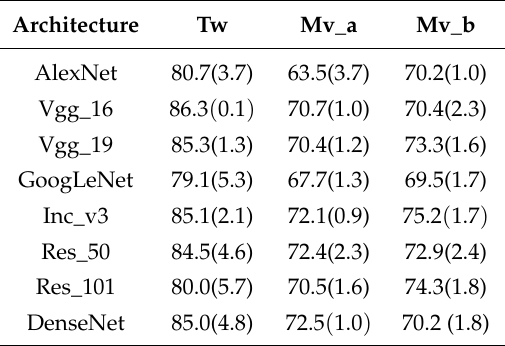
Figure 7. Consistency evaluation of the eight architectures under the layer addition configuration; the plot gives the architectures on the x -axis and the corresponding total amount of collected points on the y -axis. Table 7. Experimental results: Session #1,